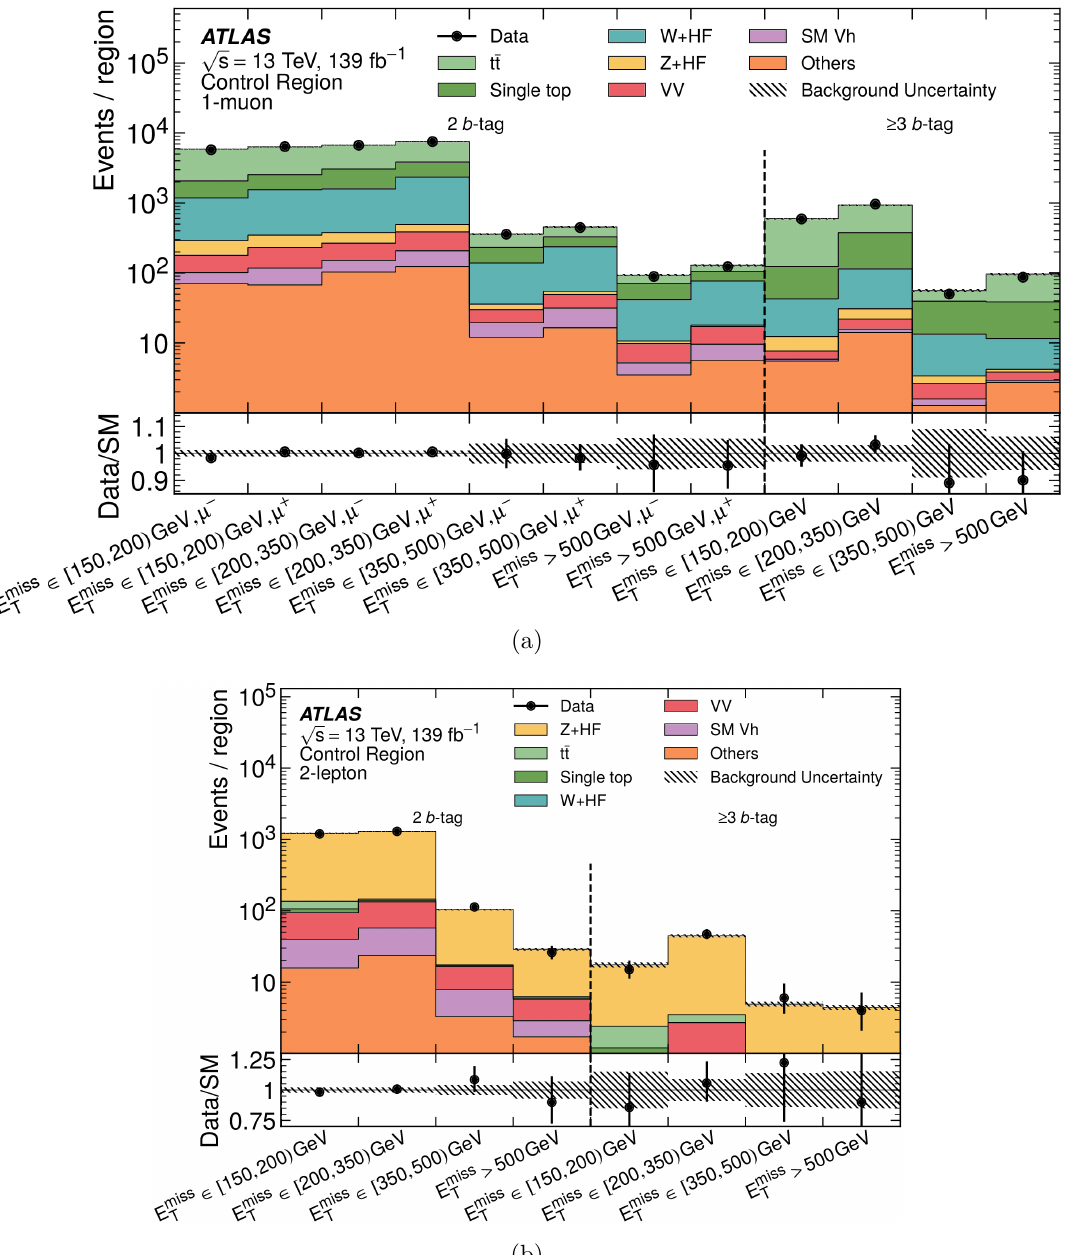
Figure 3. Yields in the resolved and merged (a) 1-muon control regions and (b) 2-lepton control regions. The top panel compares the fitted background yields with data, while the bottom panel indicates the ratio of the observed data to the predicted Standard Model backgrounds. The different control region bins included in the fit are indicated on the x -axis by first giving the range in E miss and then the sign of the muon charge (where